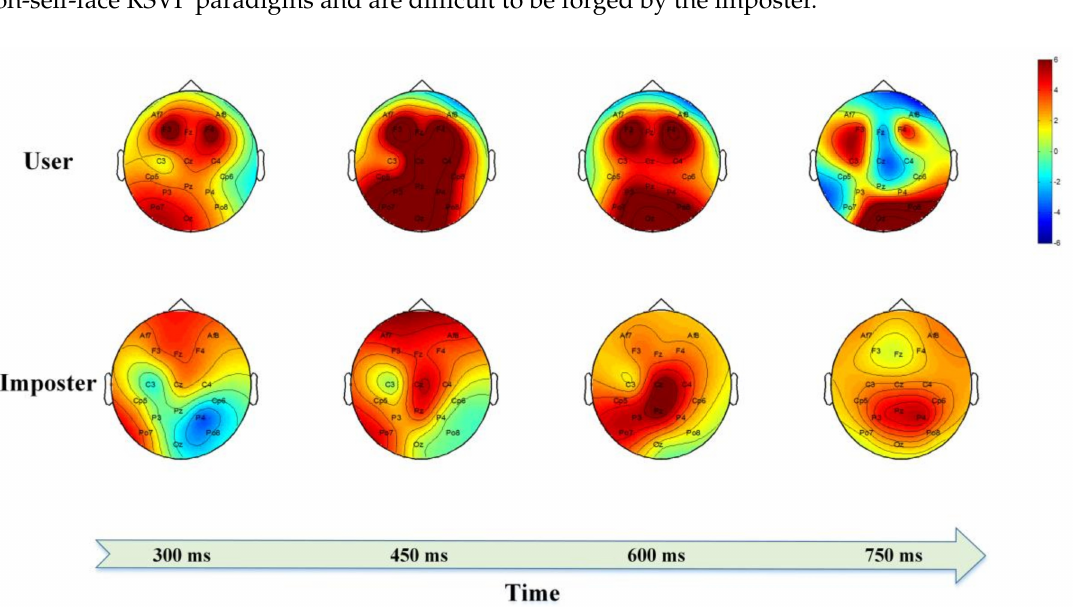
Figure 13. The ERP topographical